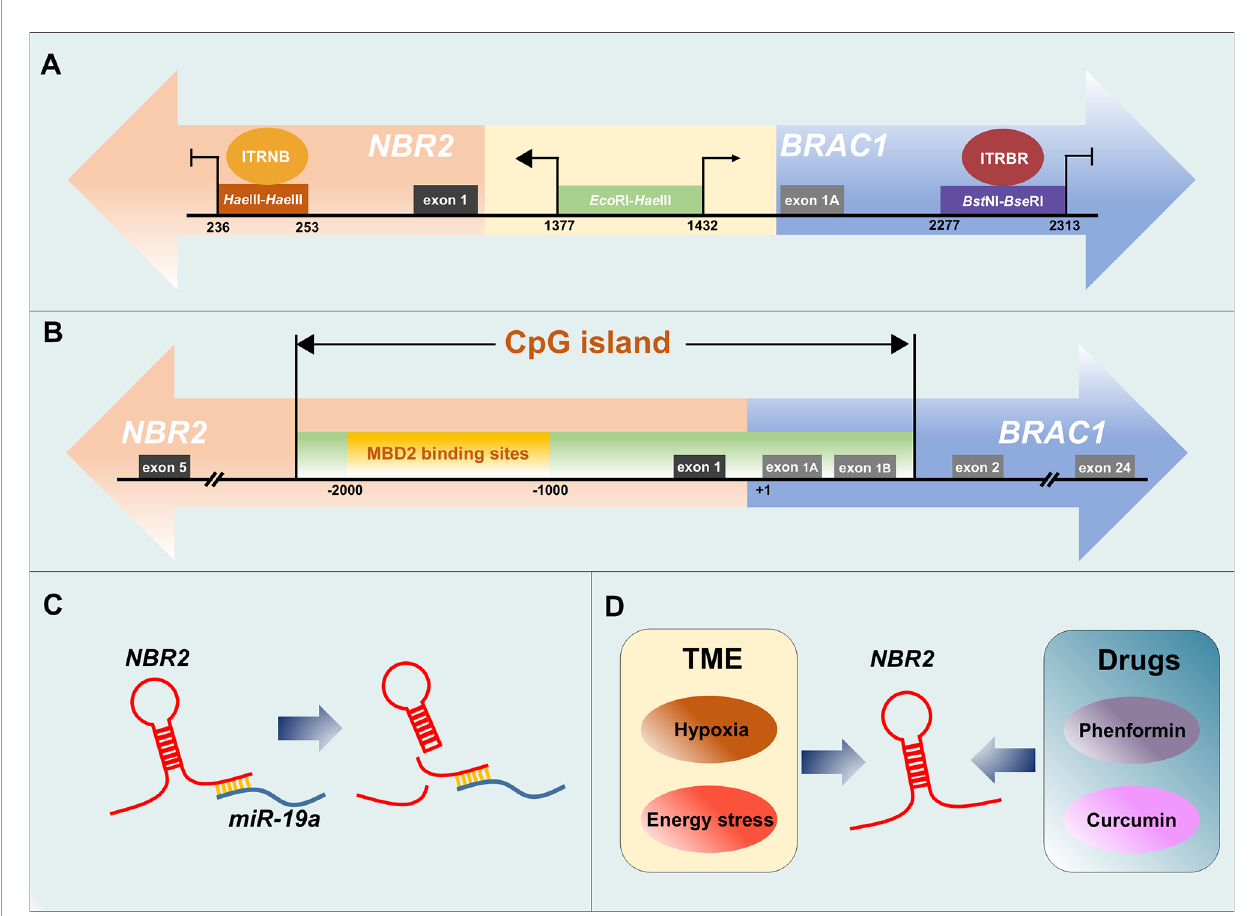
FIGURE 2 | Regulation of NBR2 expression in cancer. (A) Model of the BRCA1 – NBR2 bi-directional transcription unit. A minimal 56-bp Eco RI – Hae III fragment (nucleotides 1377 – 1432) located between NBR2 and BRCA1 genes acts as a bi-directional promoter, and it induces transcription in the NBR2 gene direction higher than that in the BRCA1 direction. An 18-bp Hae III – Hae III repressive element (nucleotides 236 – 253) that resides 948-bp into the fi rst intron of the NBR2 gene and is bound by the intronic transcriptional repressor of NBR2 (ITRNB) functions to turn off transcription only in the NBR2 direction. The 36-bp BstN I – BseR I fragment (nucleotides 2277 – 2313) that resides 575-bp into the fi rst intron of the BRCA1 gene exhibits non-tissue-speci fi c transcriptional suppressive activity only in the BRCA1 direction by binding to the intronic transcriptional repressor of BRCA1 (ITRBR). (B) MBD2 leads to the silencing of the NBR2 gene by binding speci fi cally to the methylated region of the CpG island fl anking the bi-directional BRCA1 – NBR2 promoter. Positions are indicated from the BRCA1 transcription start site. (C) MiR- 19a can interact with NBR2 and induce its degradation. (D) Some exogenous factors, such as hypoxia/energy stress in TME and antitumor drugs, can induce the expression of NBR2